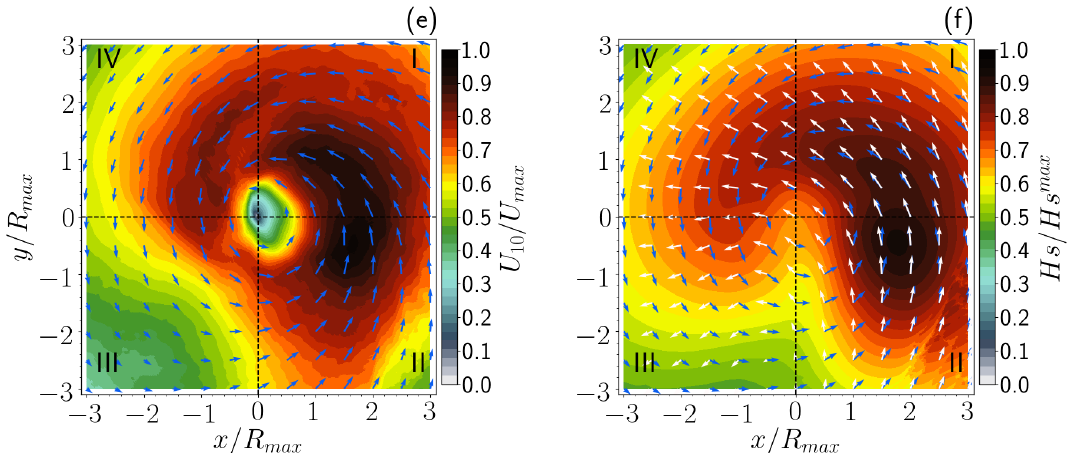
Figure 5. Wind fields ( left ) and mean significant wave height ( right ) obtained with the 3 h running mean filtered data. U 10 ( a ) and Hs ( b ) fields with an 18 h interval. Wind field ( c ) and significant wave height ( d ) for the moderate storm stage. Intensification stage for the wind field ( e ) and significant wave height ( f ).